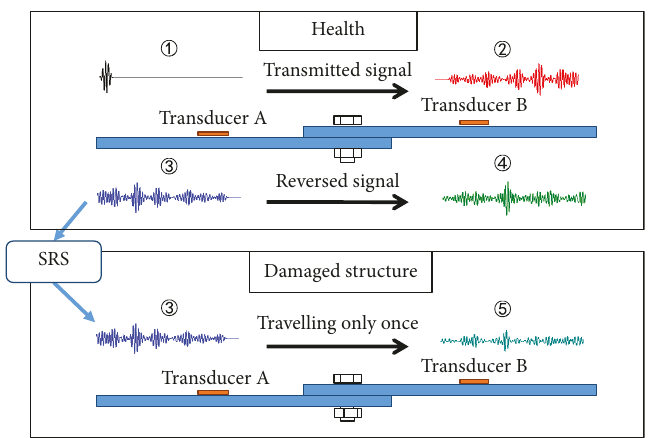
Figure 2: A schematic of the proposed method for bolt loosening